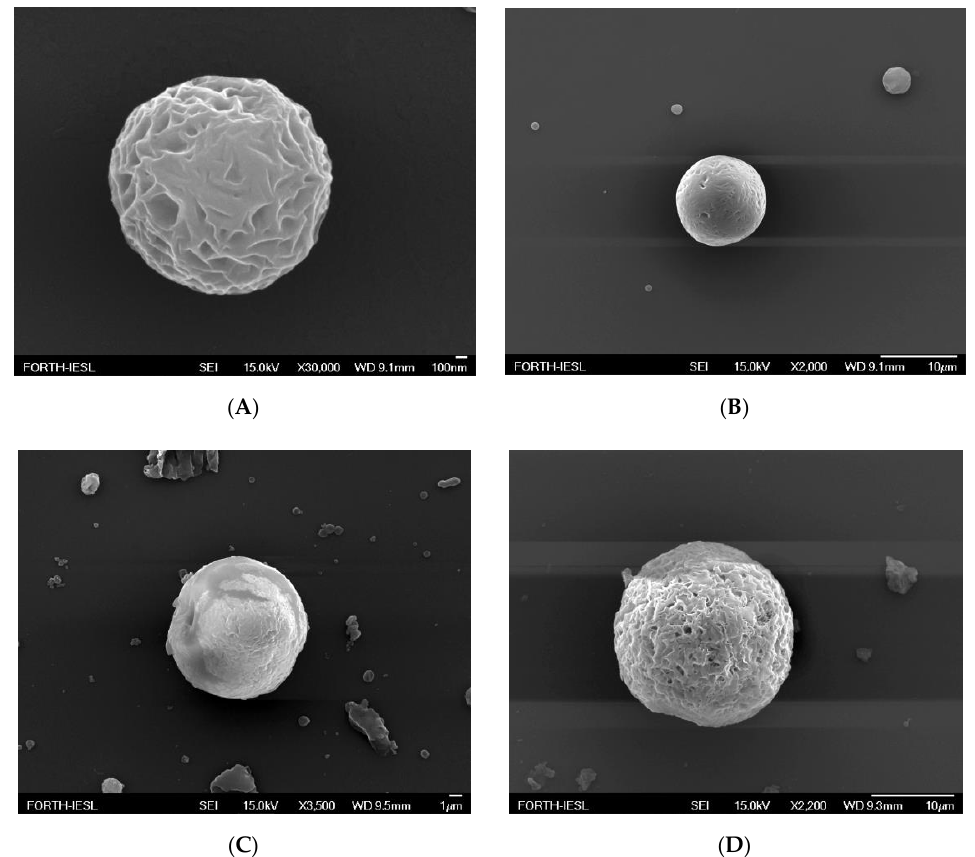
Figure 4. FESEM images of ( A ) EPCL/PVAMCs, scale bar: 100 nm, ( B ) ChrPCL/PVAMCs, scale bar: 10 µm, ( C ) EPHB/PVAMCs, scale bar: 1 µm, and ( D ) ChrPHB/PVAMCs, scale bar: 10 µm.